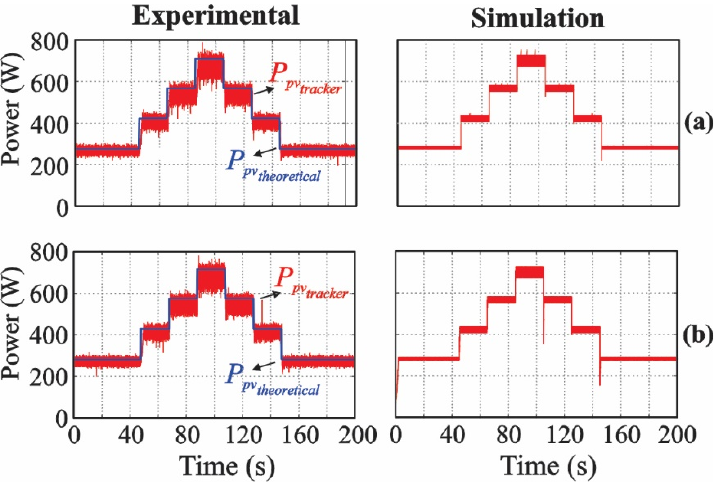
Figure 11. Experimental and simulated results regarding the PV array output power under irradiance changes: ( a ) current sensorless proposed algorithm; ( b ) classical IncCond Table 6. Comparison between the proposed and the classical IncCond algorithms under steps of irradiance.